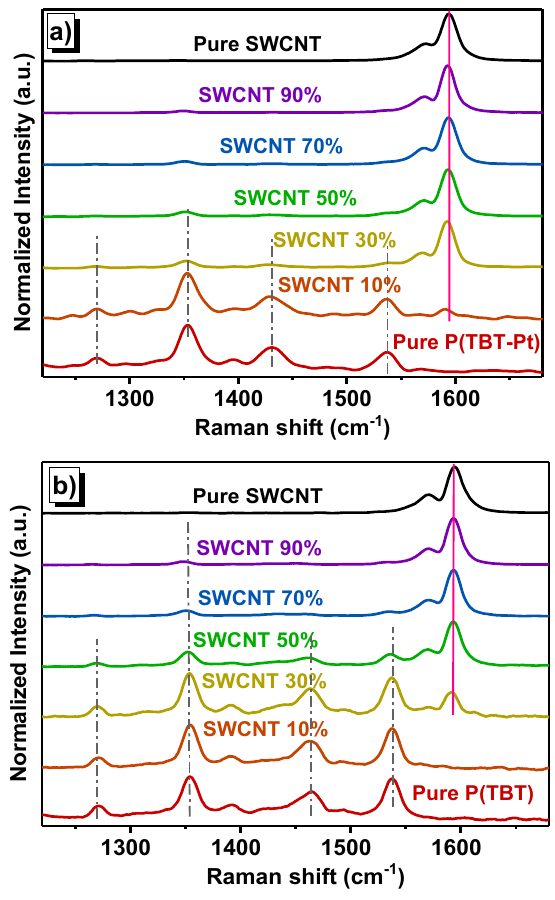
Figure 6. Raman spectra of the ( a ) P(TBT-Pt)/SWCNT and ( b ) P(TBT)/SWCNT composite films.